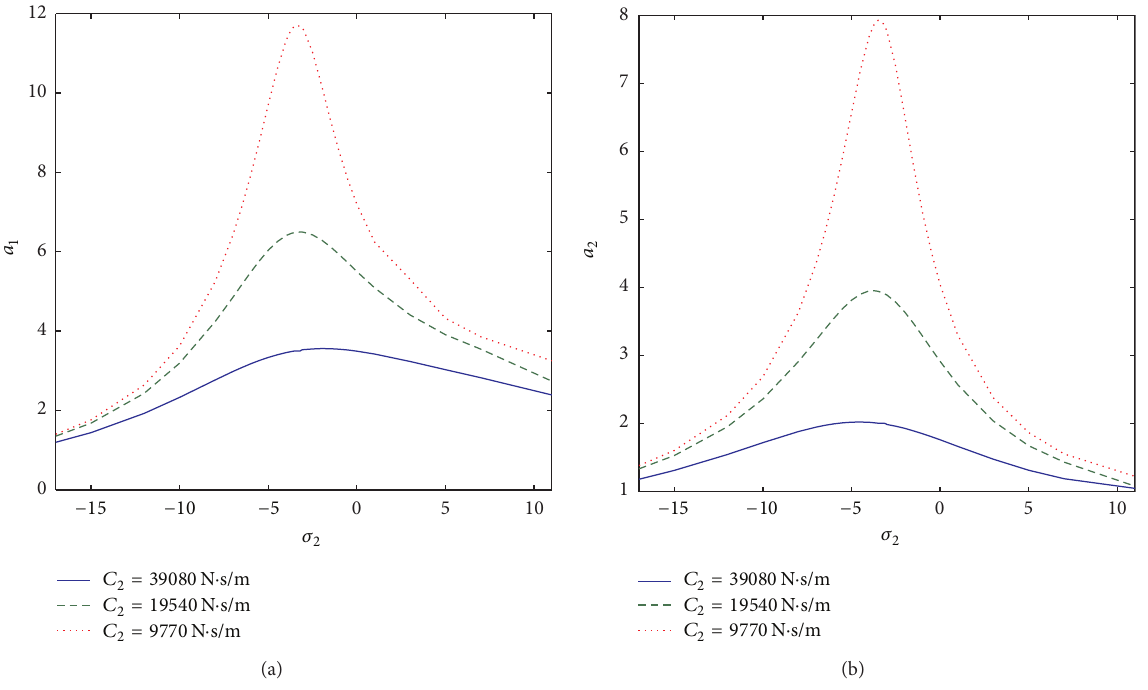
Figure 8: The influence of rubber damping shock absorber’s damping.